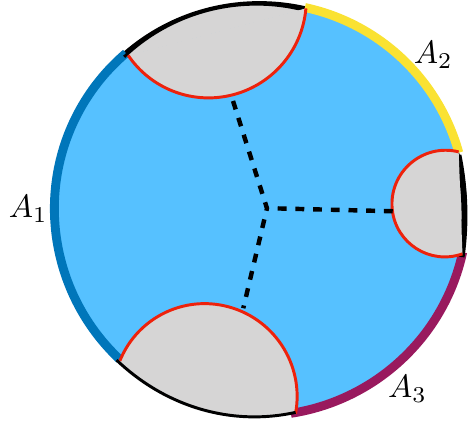
Figure 26 . An example of a class of surfaces in the bulk which allow for bulk intersection